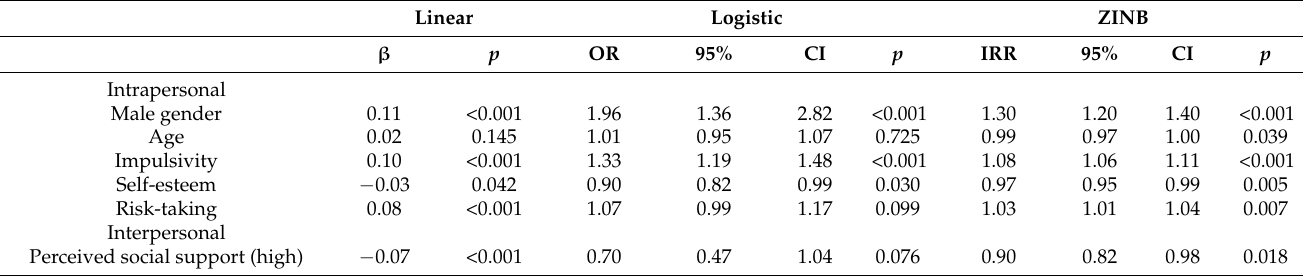
Table A2. Alternative linear, logistic, and zero-inflated negative binomial regression models predicting gambling